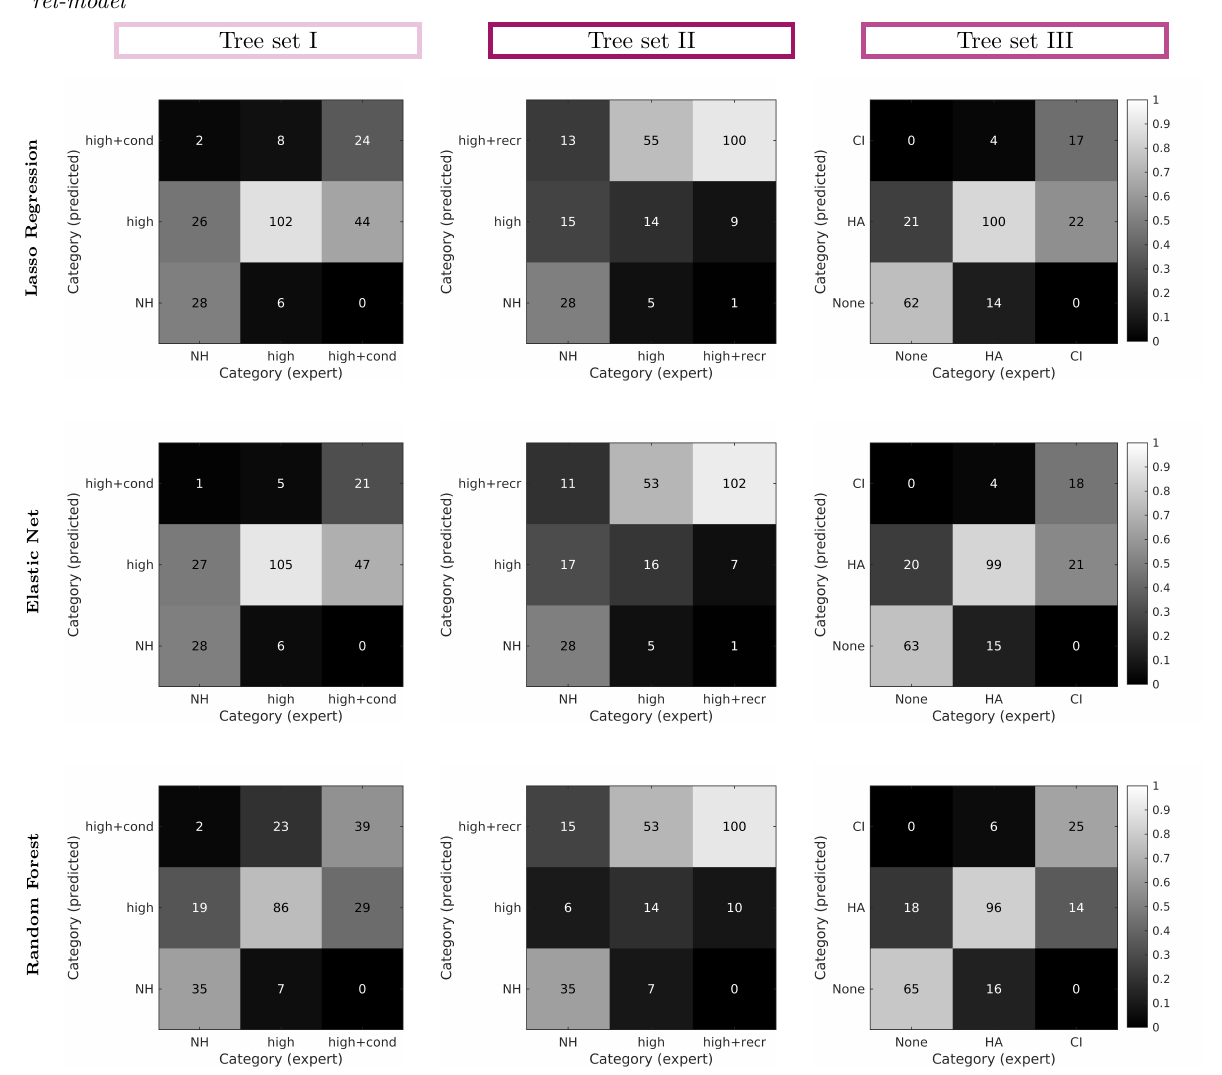
Figure 8. Confusion matrices of classified categories based on expert-estimated CAFPAs vs. predicted CAFPAs by the different prediction models. Numbers of patients (per expert category) are normalized within each column (represented by the grey scale), while absolute numbers are depicted as text. Different columns of the overall plot represent different tree sets, while different rows represent different CAFPA prediction models. Results are depicted for rel-model weights. Results for the remaining weights are provided in Table